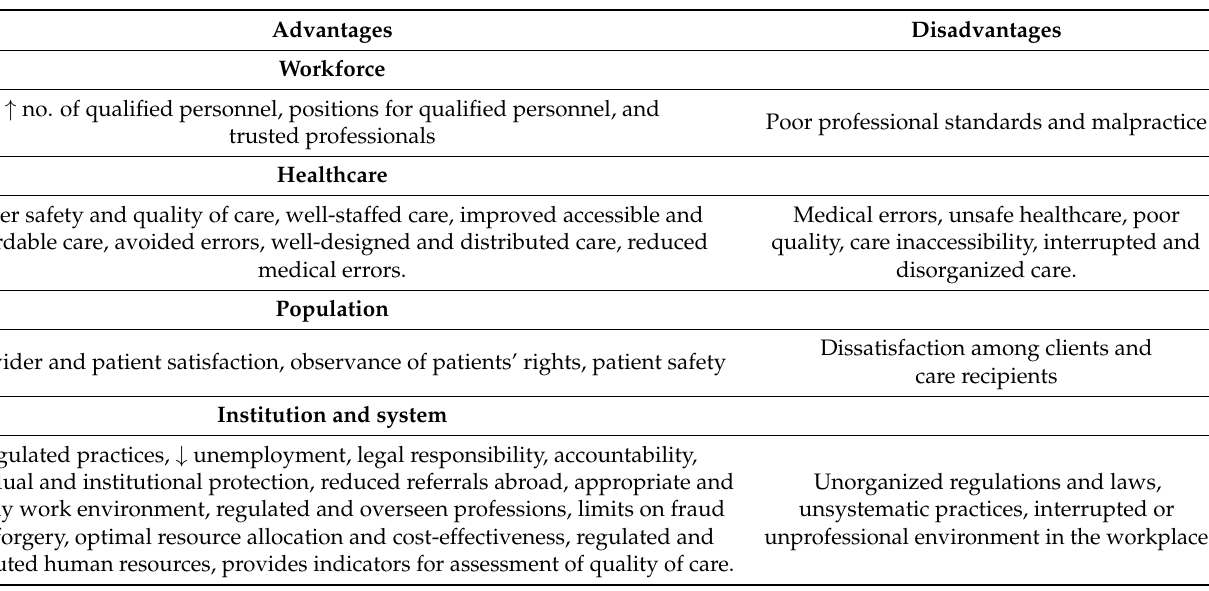
Table 2. Perceptions of disadvantages and advantages of the HWAR system and